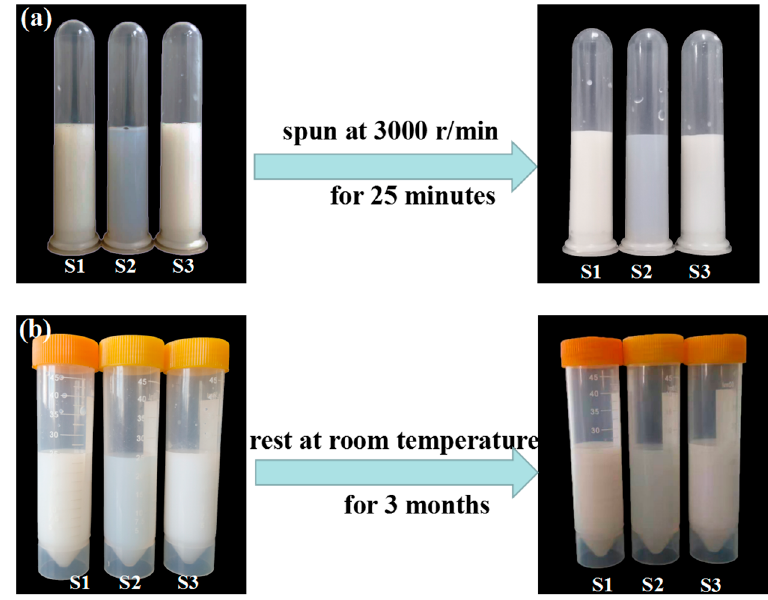
Figure 3. Pictures of S1, S2 and S3 before and after spun at 3000 r / min for 25 minutes ( a ), and storage at room temperature for 3 months ( b ).